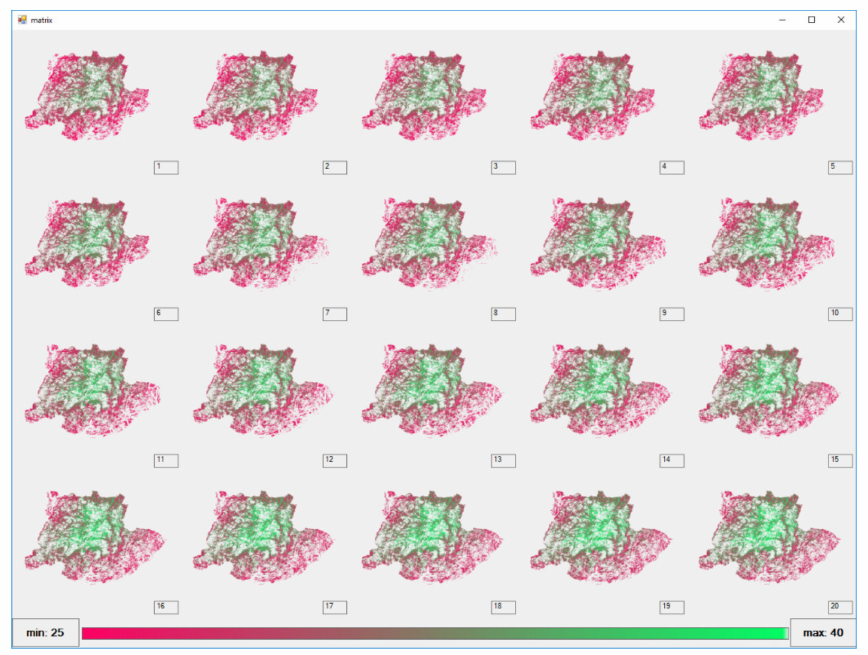
Figure A10. Price distribution for Scenario 1 (Biomass III (S 1 ), felling) over a period of 20 years (t 1 to t 20 ) in the Nordeste region, Portugal. The minimum price was 12 € / m 3 (light red) and the maximum 22 € / m 3 (light